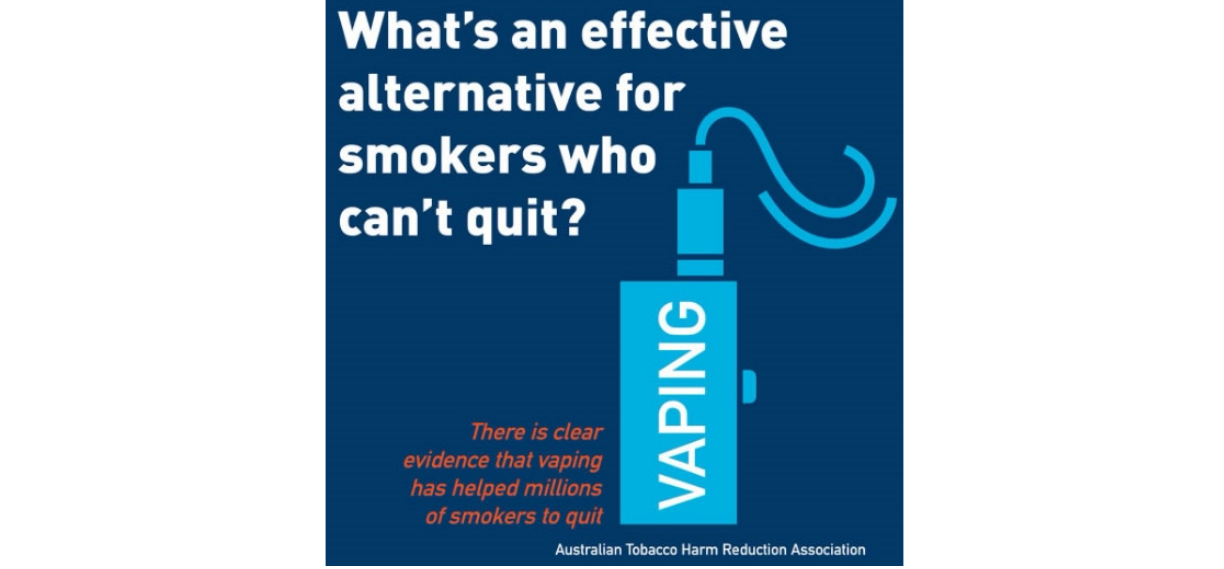
Figure 6. Example of describing e-cigarettes as a smoking cessation aid within the “health, safety, and product claims” domain.